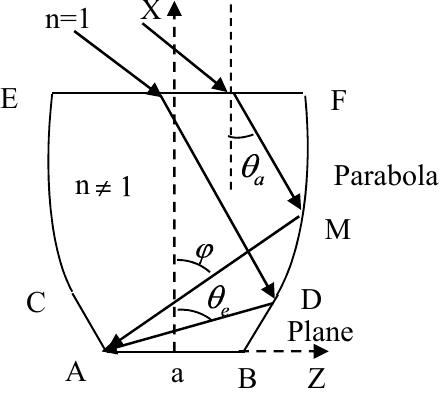
Figure 1 . Geometry of DCPC- Figure 1. Geometry of DCPC- θ a / θ e .